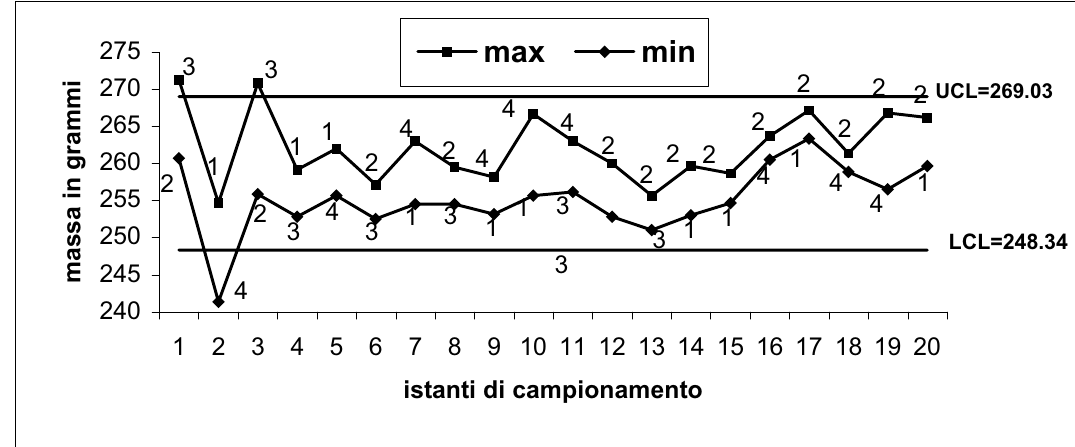
Figura 3 – Carta x costruita con lo stimatore di variabilità